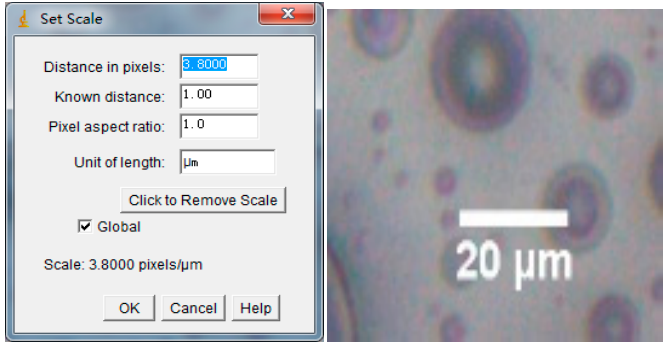
Figure 6. Set the scale.